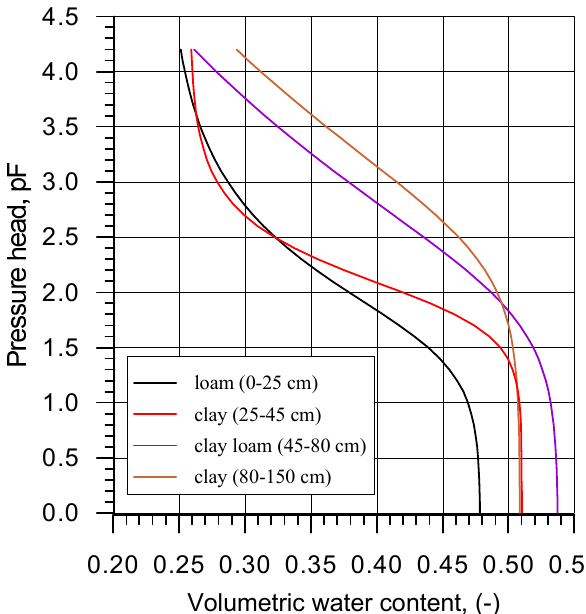
Figure 2. Soil moisture retention curves for individual soil layers.